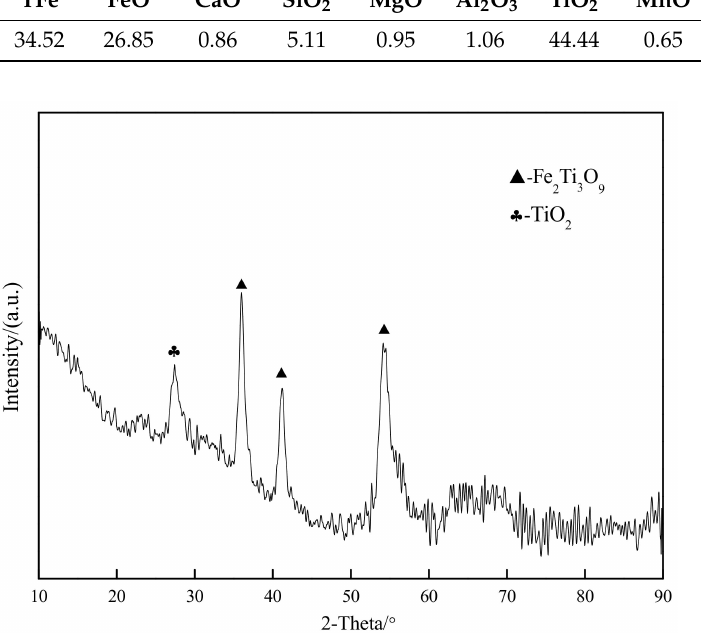
Figure 1. XRD pattern of synthetic pseudorutile powder.